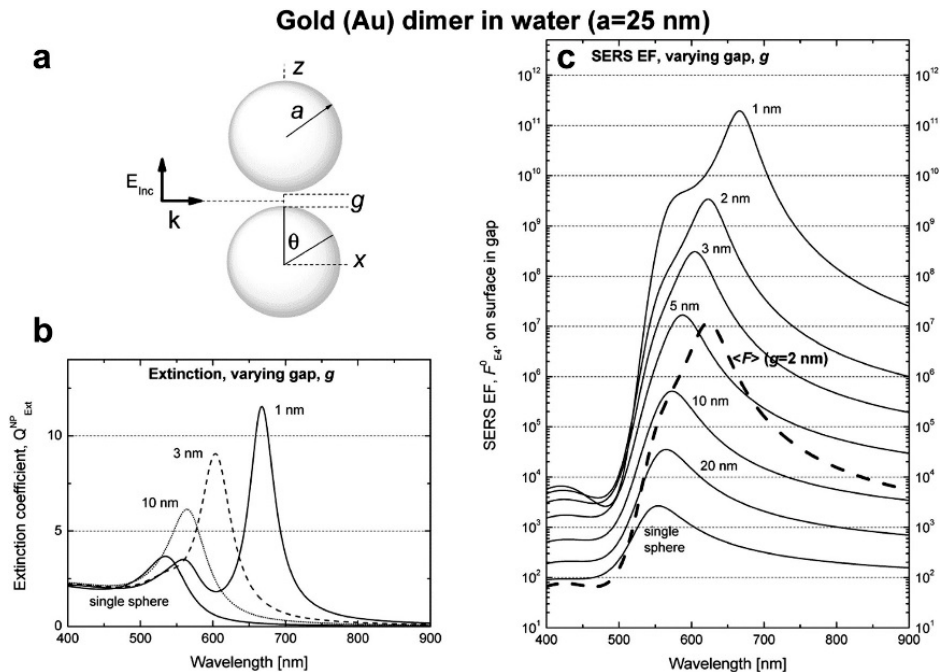
Figure 12. ( a ) The dimer under investigation is formed by two gold nanoparticles with radius 𝑎 and separated by a gap 𝑔 ; the laser is polarized along the main axis. ( b ) Extinction coefficient for a single sphere and for the dimer (with different gaps) as a function of the wavelength. ( c ) Continuous lines: SERS enhancement (SERS EF in the figure) for a single sphere and for the dimer (with different gaps) as a function of the wavelength; the enhancement is calculated at the point where the surface of one of the two nanoparticles crosses the axis 𝑍 . Dashed line: SERS enhancement for the dimer with 𝑔 = 2 nm, averaged over the whole metallic surface. Reproduced with permission from Le Ru et al. [6]. Copyright (2009) Elsevier